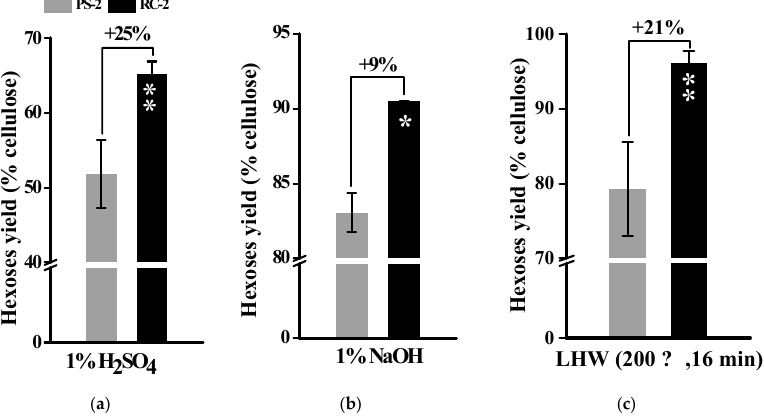
Figure 6. Comparison of hexoses yields (% cellulose) released from enzymatic hydrolysis after chemical and LHW pretreatments between PS-2 and RC-2 samples; ( a ) 1% H 2 SO 4 pretreatment; ( b ) 1% NaOH pretreatment; ( c ) LHW pretreatment; * and ** As significant differences between the RC-2and PS-2 by Student’s t -test at p < 0.05 and 0.01 ( n = 3) with the increased (+) percentage of the RC-2 sample relative to the PS-2; Data as means ± SD ( n = 3). Table 3. Cell wall composition (% total) in the PS-2 and RC-2